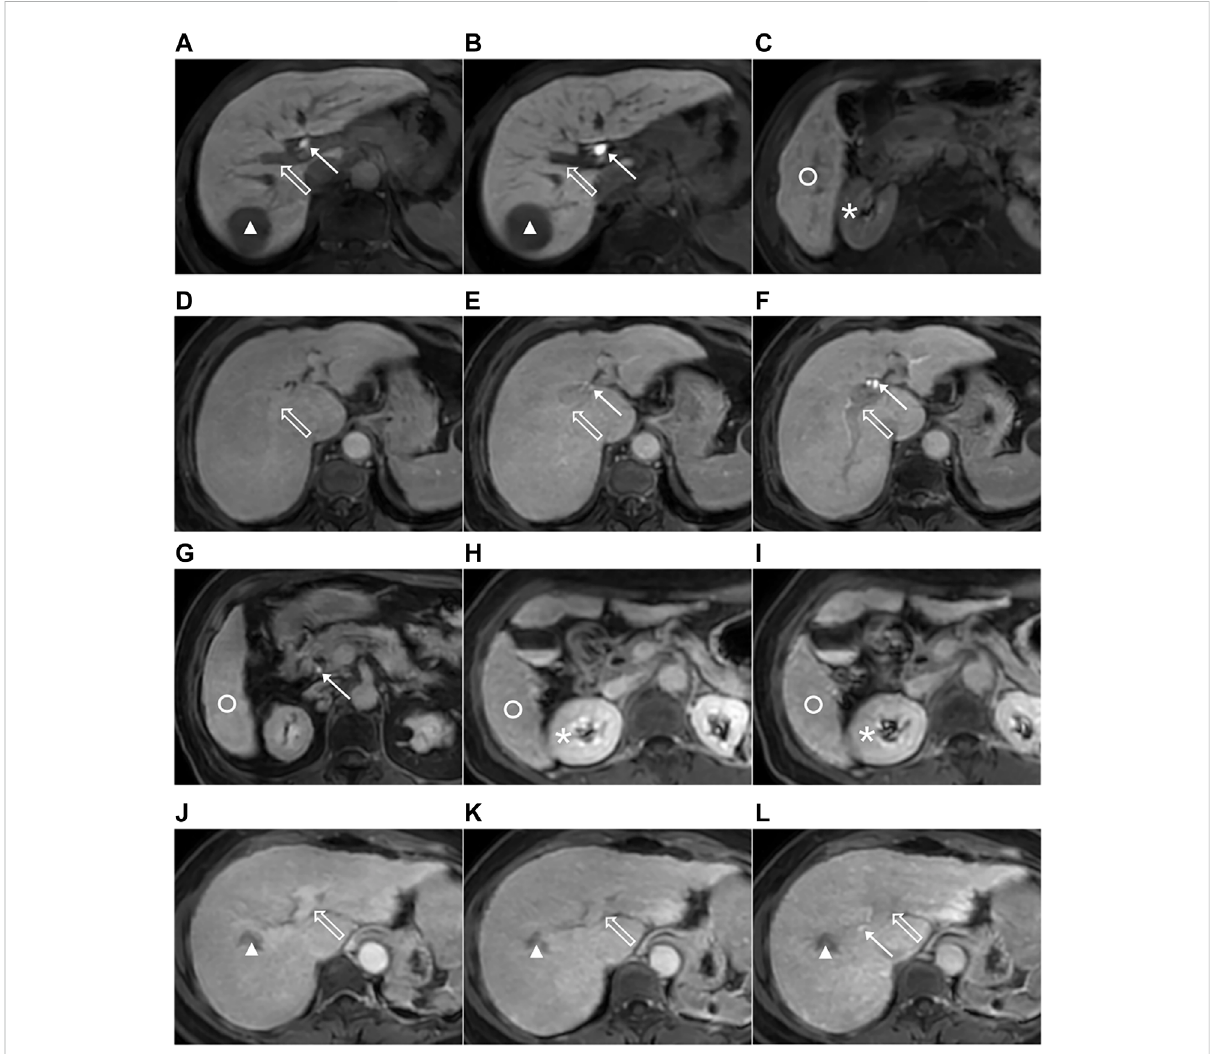
FIGURE 2 Images from 3.0-T MRI that wereobtained 5, 10,and 15 min after gadoxeticacid was administrated within axial planes in the three patients that suffer from the chronic liver disease or the liver cirrhosis. The 51-year-old man that suffer from the chronic hepatitis B, hepatocellular carcinoma (HCC) (triangle), ICG-R 15 of 3.6%, ALBI grade 1, CP A cirrhosis and MELD score of 8 with the functional liver imaging score (FLIS) of 6 at 5 (A,C) , 10 (B) and 15 min (not shown). Liver parenchymal enhancement quality score (EnQS) is 2 at each time point due to that the signal intensity of the liver (circle) ishigher comparedto that oftherightkidney (*). Excretion qualityscore (ExQS)is2ateach time pointdue to that thecontrast mediais found tobewithinthecommonbileduct(solidarrow).Portalveinsignqualityscore(PVsQS)is2ateachtimepointduetothattheportalvein(hollowarrow) is seen to be hypointensed to theliver parenchyma (circle). A 78-year-old woman with cryptogenic liver disease, HCC (not shown), ICG-R 15 of 6.8%, ALBI grade 2, CP A cirrhosis and MELD score of 15 with functional liver imaging score (FLIS) of 2, 3and 5at 5 (D) , 10 (E) and 15 min (F,G) , respectively. EnQSis1ateachtimepointduetothatthereisequalsignalintensityoftheliver(circle)andtherightkidney(*).ExQSis0,1,and2at5,10,and15 min, respectively, due to that contrast media is not presented, excreted into the intrahepatic bile ducts and common bile duct respectively (solid arrow). PVsQS is 1 at 5 and 10 min and 2 at 15 min due to that the portal vein (hollow arrow) is found to be both isointense and hypointense to the liver parenchyma(circle), respectively. A 59-year-oldwomanthat suffers from thehepatitis C virus cirrhosis, HCC (triangle),ICG-R 15 of21.0%,ALBI grade 2, CP A cirrhosis and MELD score of 7 with the functional liver imaging score (FLIS) being 0, 1 and 3 at 5 (J) , 10 (H,K) and 15 min (I, L) , respectively. EnQSis0at5and10 minand1at15 min duetothatthesignal intensity oftheliver(circle)isbothlowerthanandequalsto thatoftherightkidney (*), respectively. ExQS is 0 at 5 and 10 min and 1 at 15 min because contrast media is not shown and excreted into the intrahepatic bile ducts (solid arrow). PVsQS is 0 at 5 min and 1 at 10 and 15 min due to that the portal vein (hollow arrow) is both hyperintens and isointense to the liver parenchyma (circle),